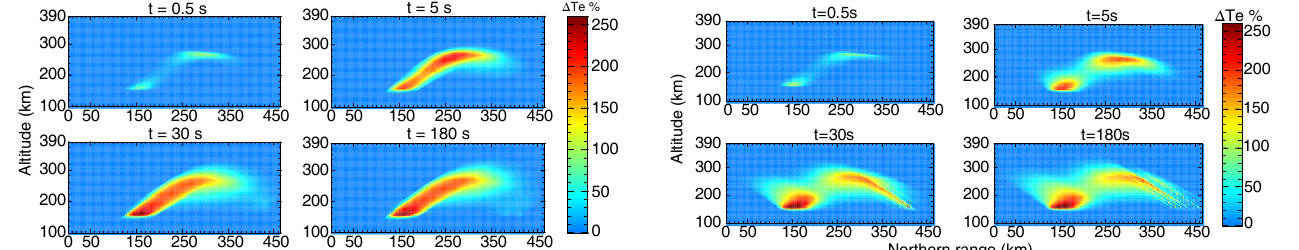
Figure 5. The evolution of the ionospheric electron temperature changes in the center meridian plane with heating wave incidence parallel to the magnetic field line at different heating duration times.